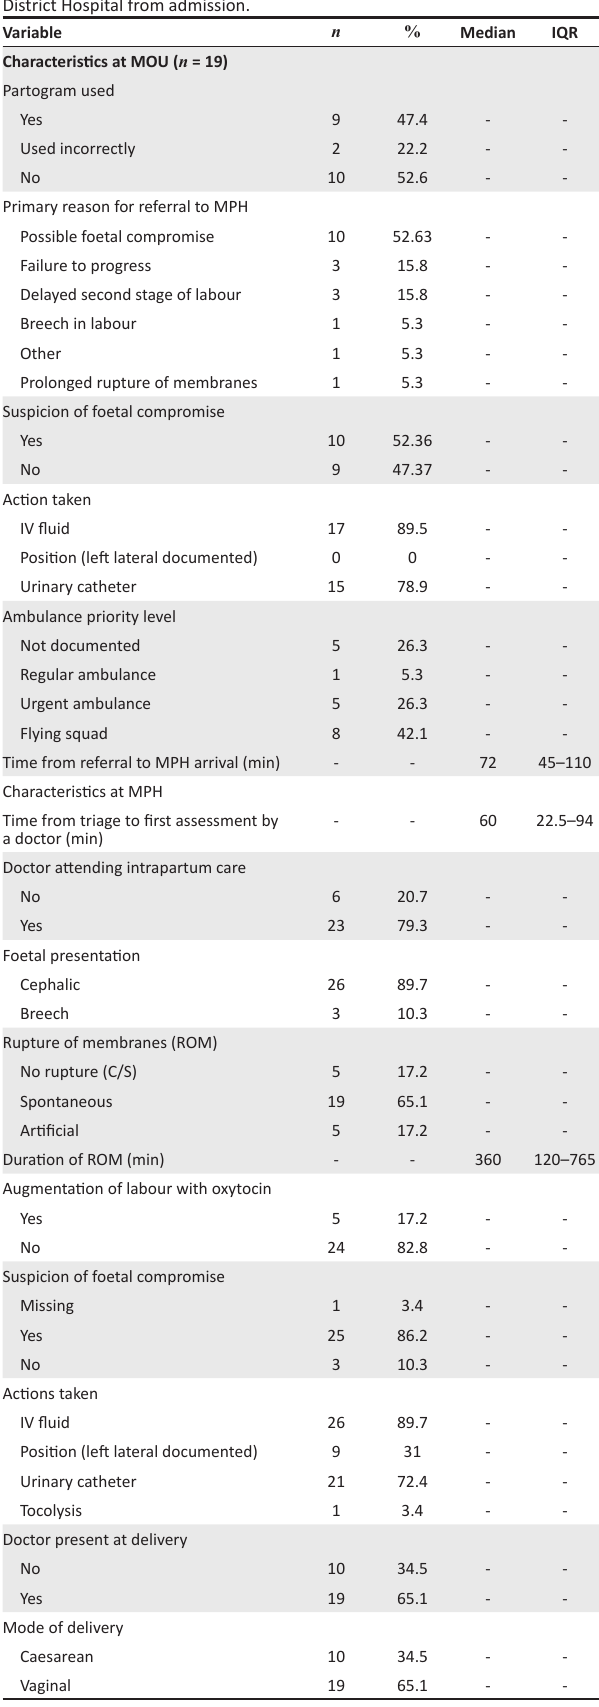
TABLE 2: Course of clinical care at midwife obstetric units and Mitchells Plain District Hospital from admission.